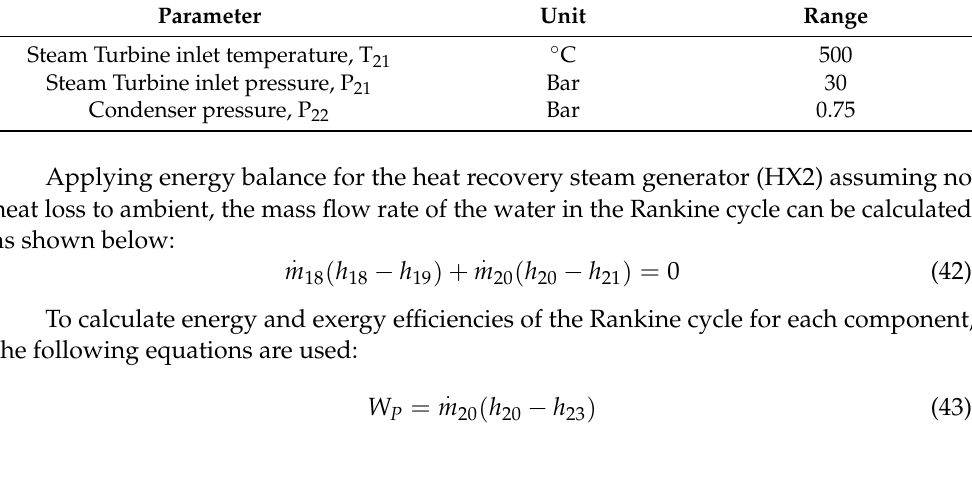
Table 6. Constant values for the Rankine cycle [37]. Parameter Unit Range Steam Turbine inlet temperature, T 21 ◦ C 500 Steam Turbine inlet pressure, P 21 Bar 30 Condenser pressure, P 22 Bar